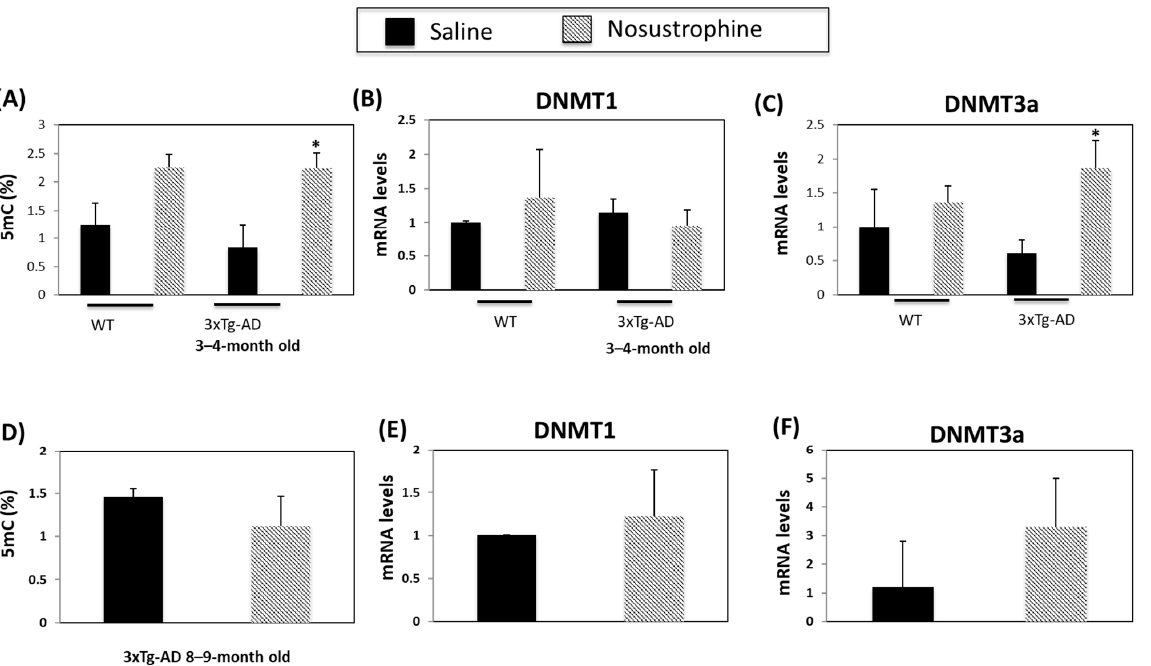
Figure 8. Nosustrophine regulates DNA methylation. Global DNA methylation (5mC) levels were measured in wild-type, and young (3–4-month-old) ( A ) and older (8–9-month-old) mice ( D ) 3xTg-AD mice ( n = 4 animals per group) and expressed as percentages. DNMT1 and DNMT3a mRNA levels were also measured by qPCR in wild-type and young ( B , C ) and old ( E , F ) 3xTg-AD mice. Results are expressed as fold-change compared to saline-treated wild-type- or trigenic mice. Data are expressed as means ± S.E.M. * p < 0.05.